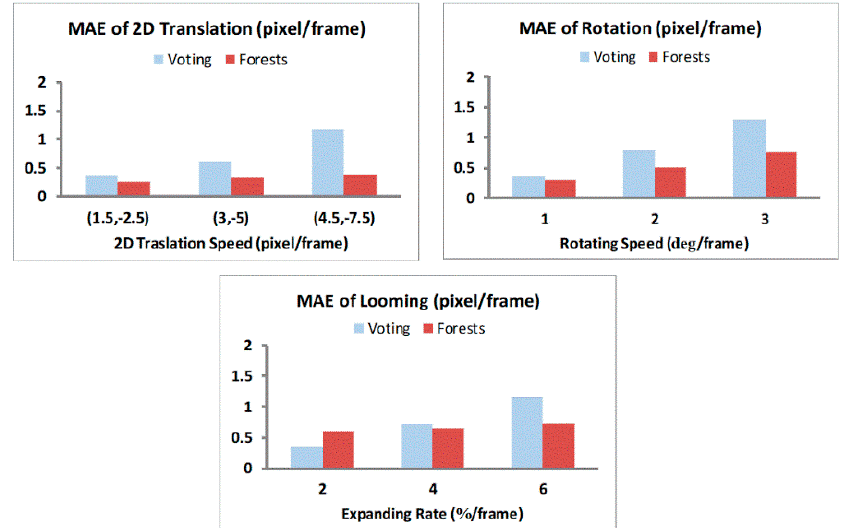
Figure 2. Mean Absolute Errors (MAE) of optical flow computation for 1D horizontal translation at different speeds from − 8 to 8 pixel/frame with a step of 0.5 pixel/frame.